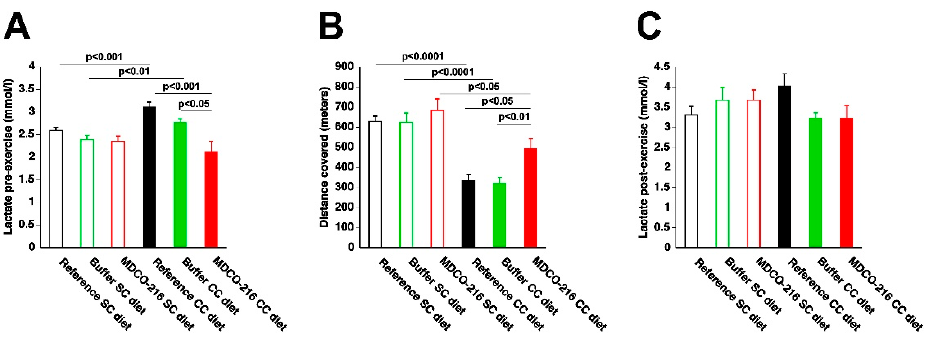
Figure 9. Lactate pre-exercise ( A ), distance covered ( B ), and lactate post-exercise ( C ) in C57BL/6 SC diet mice and in C57BL/6 CC diet mice. SC diet mice and CC diet mice are indicated by open bars and closed bars, respectively. All data represent means ± SEM ( n = 15).